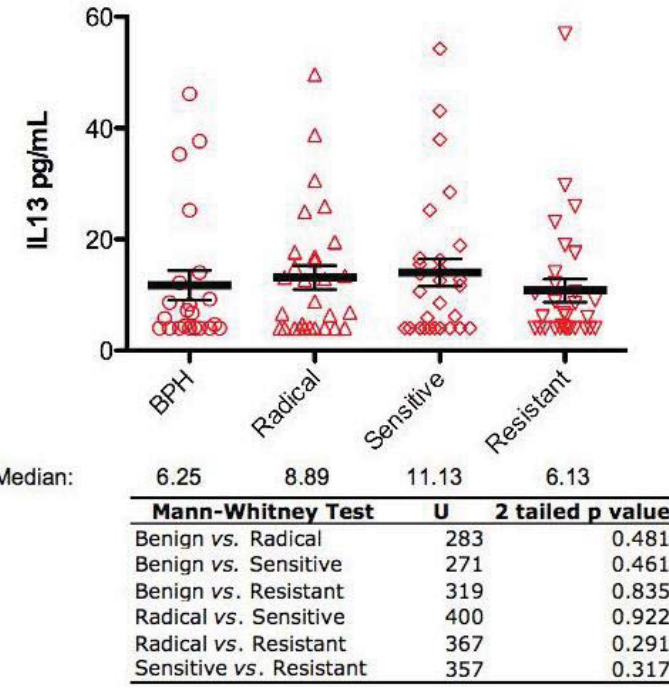
Figure 2. Serum IL-13 levels in patients with benign and malignant prostate disease. Each symbol in the dot plot represents the serum level as measured by ELISA for an individual patient. Results are expressed as median (horizontal line), flanked by the inter-quartile range. Differences were calculated using the Mann-Whitney U Test and are shown in the table as 2-tailed p